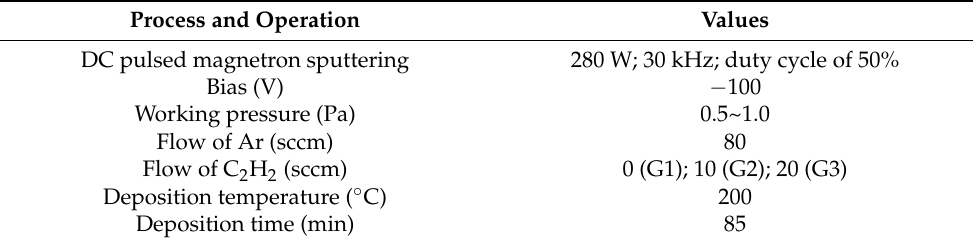
Table 1. The process parameters of DLC film preparation.